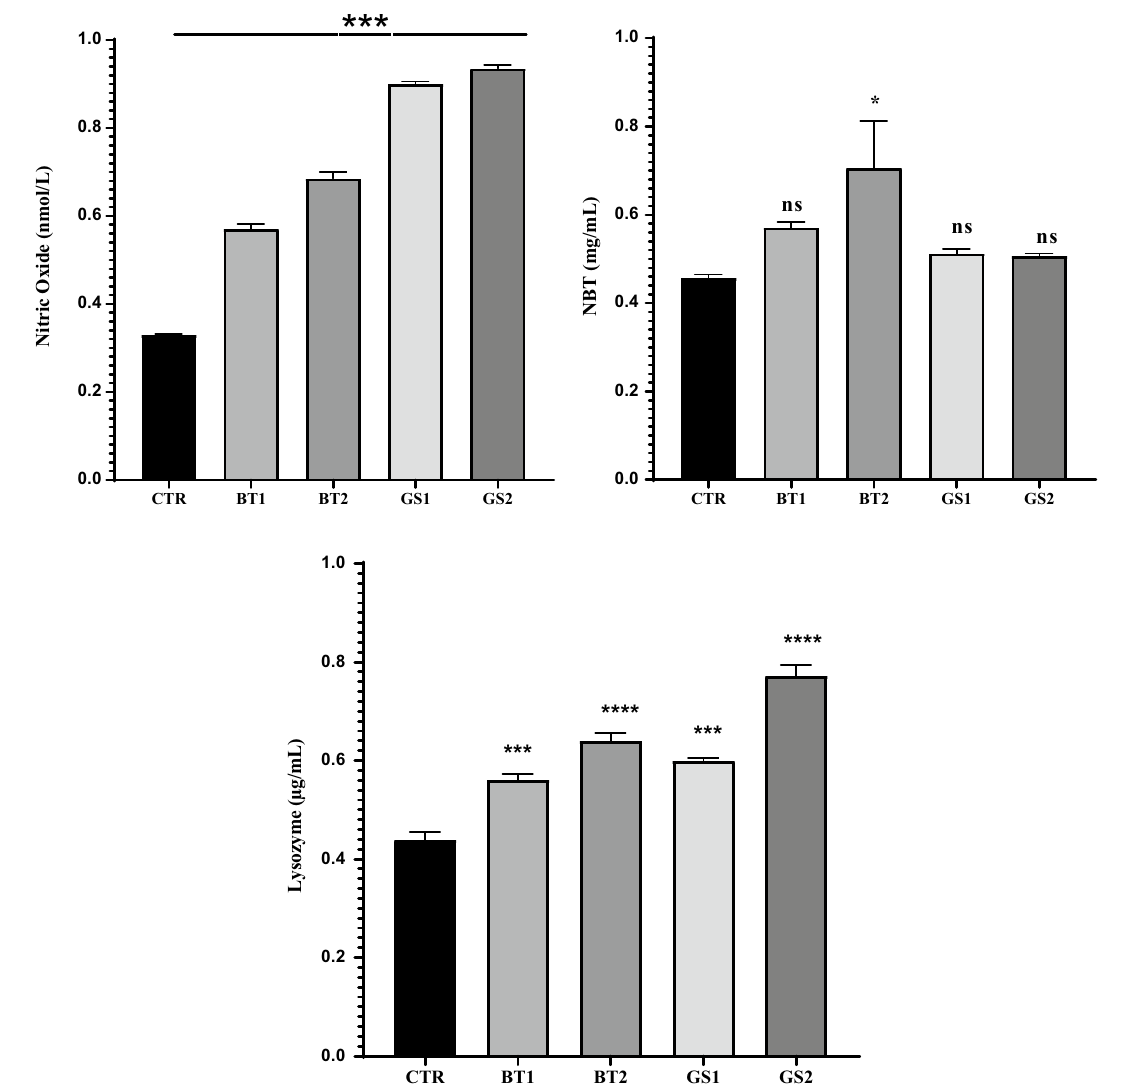
Fig. 4 Effects of supplemented tilapia rearing water with two probi- otic strains (BT, B. toyonensis and GS, G. stearothermophilus ) at lev- els of 1 or 2 × 10 5 CFU ml −1 on nitric oxide, NBT, and lysozyme con- centrations. The Dunnett's multiple comparison of group means was